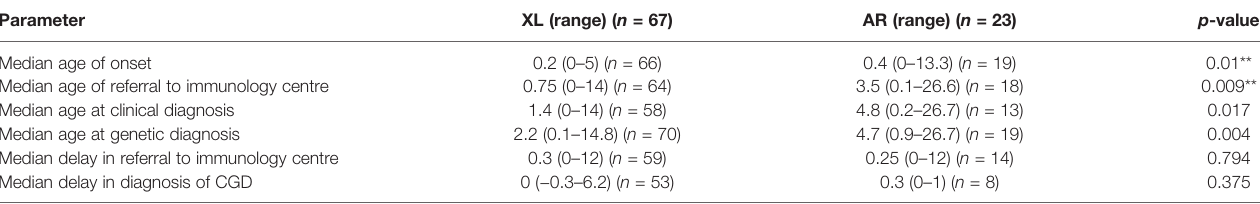
TABLE 2 | Comparison between clinical characteristics between XL-CGD and AR-CGD using Fisher ’ s exact test. Parameter XL (range) ( n = 67) Median age of